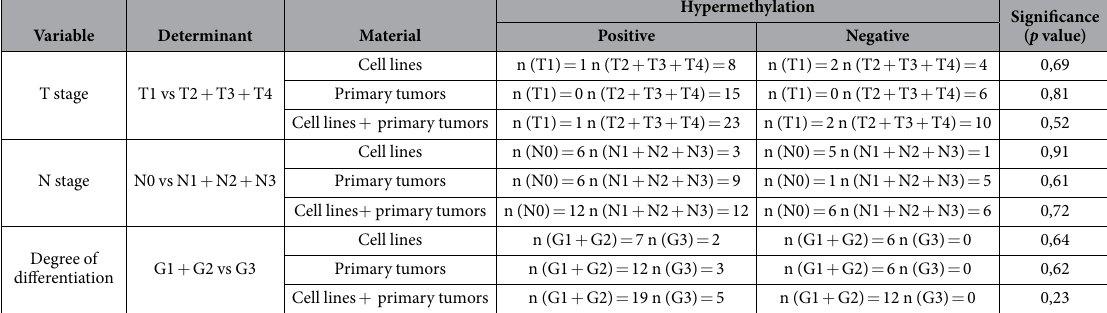
Table 2. The relationship between the FAM107A methylation and tumor